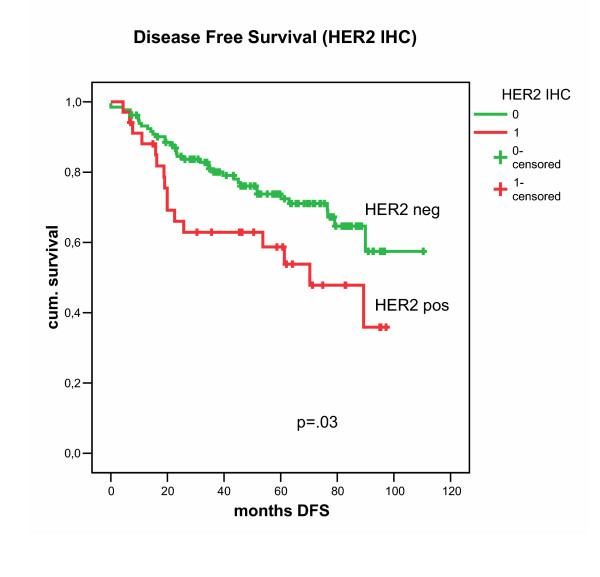
Correlation of disease free survival (DFS) with HER2 immunohistochemistry (IHC) results. Cum, cumulative; neg, negative; pos, positive.